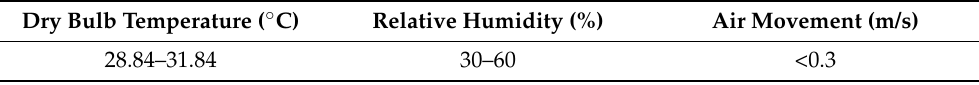
Table 2. The summer indoor conditions recommended according to ASHRAE 55